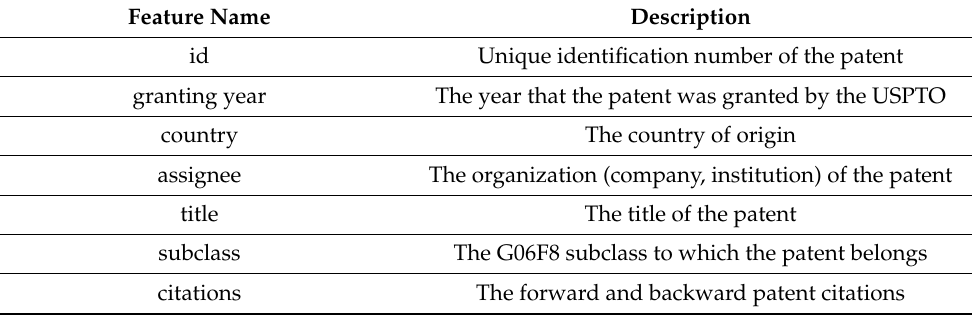
Table 2. Extracted features from patent